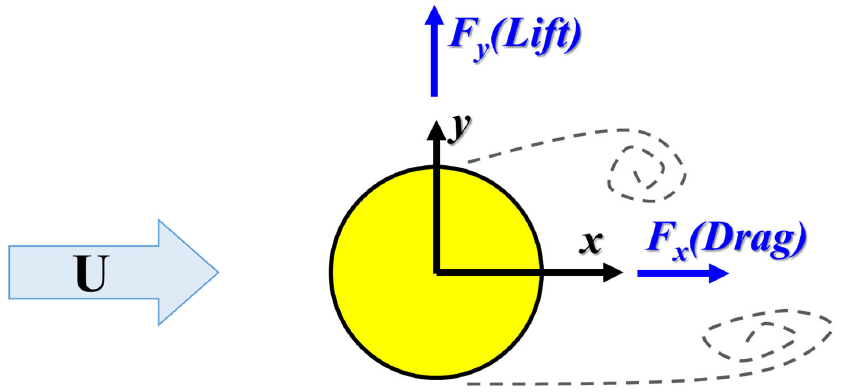
Figure 1. Circular cylinder with incoming flow.